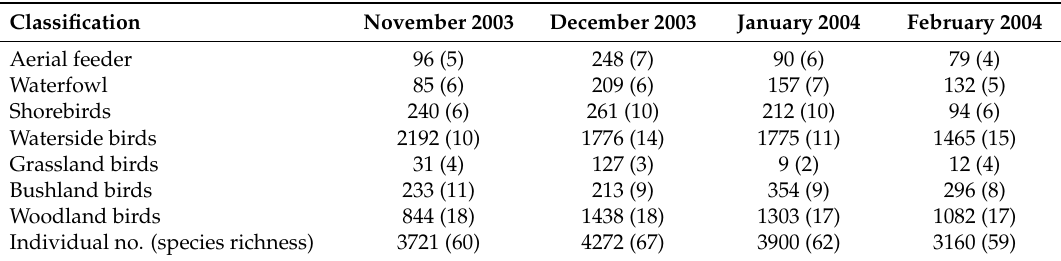
Figure 2. Dendrogram showing the classification of avian data. The Ward method was used with the distance (dissimilarities) index in seven functional groups including 94 species in the study area. Table 3. Individual numbers and species richness of avian guilds in each month.